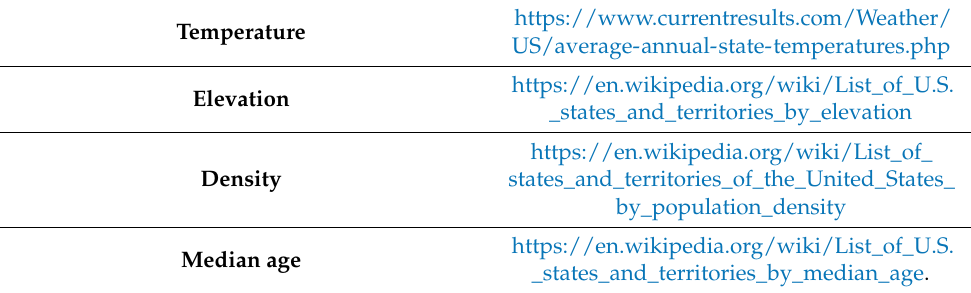
Table 1. Web sites for data sources, accessed on 20 August